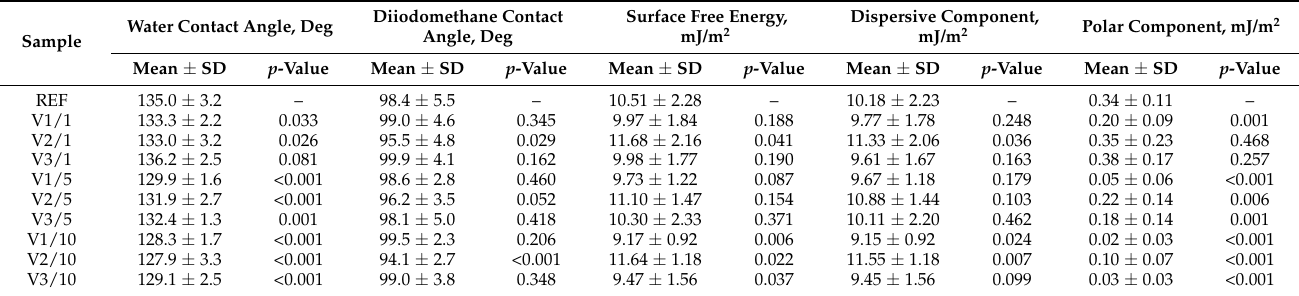
Table 9. Analysis of statistical significance ( p -value) of the changes in water and diiodomethane contact angles, surface free energy values, and components, based on Student’s t -test (N =